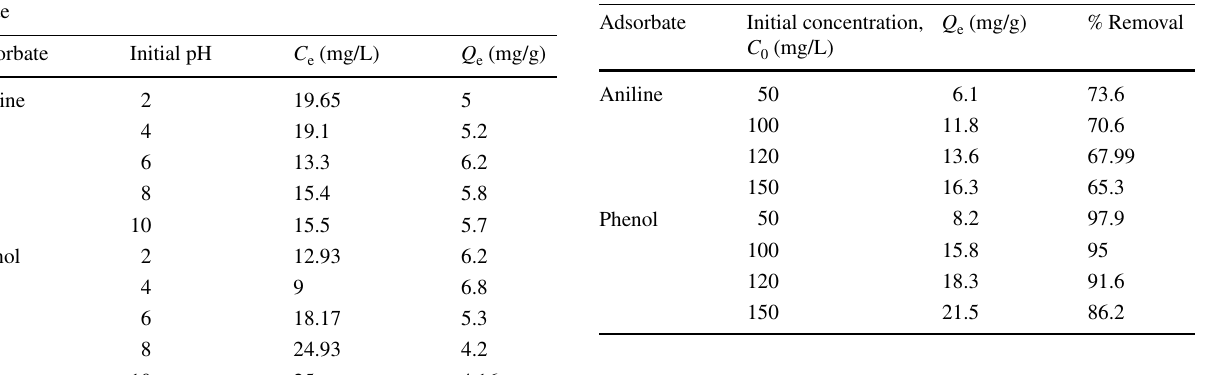
Fig. 3 Effect of initial concentration on removal efficiency of pollut- ants by bentonite (time = 60 min, dosage = 0.6 g/L, optimum pH) Table 3 Effect of initial concentration on aniline and phenol removal by